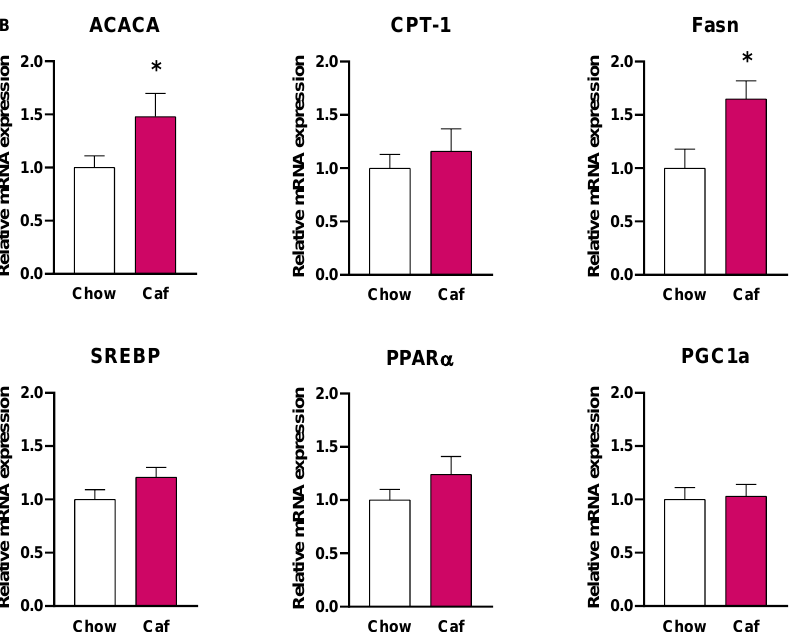
Figure 11. Liver ACACA, CPT1, Fasn, SREBP, PPAR α , and PGC1a mRNA expression in males ( A ) and females ( B ) at PND 20, in Chow (11 male, 12 female) and Caf (10 male, 7 female) offspring. Data are expressed as mean ± SEM and were analysed by independent t -test. * p < 0.05 main effect of maternal Caf diet. A distinct pattern was observed in the livers of adult (14 week) offspring. Here, male offspring born to Caf fed dams showed significantly lower relative expression of CPT-1 (F = 6.13, p < 0.05), but no significant changes in ACACA, Fasn, SREBP, and CD36 (all p > 0.05). There was no significant effect of maternal diet on liver gene expression in females. Moreover, no significant effect of postweaning diet on liver gene expression was observed in either sex (Figure 12).